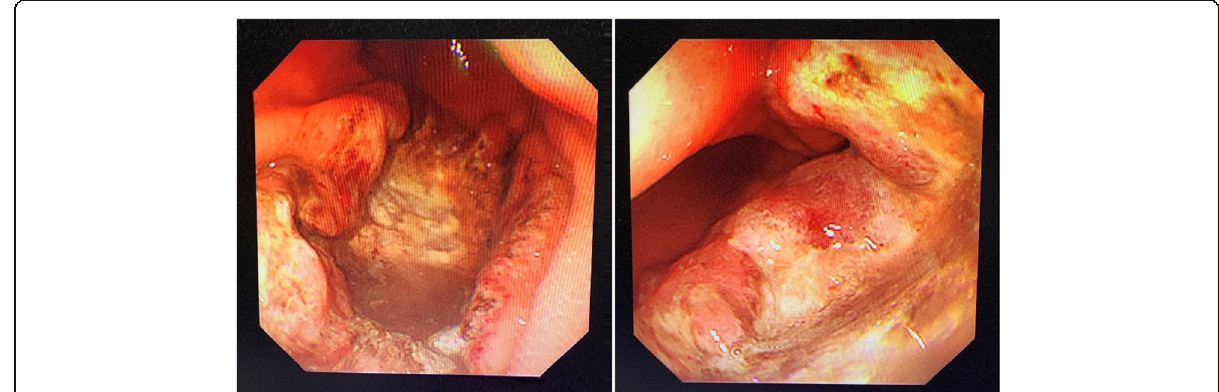
Fig. 2 Upper gastrointestinal endoscopy showed a giant serpentine ulcer in the